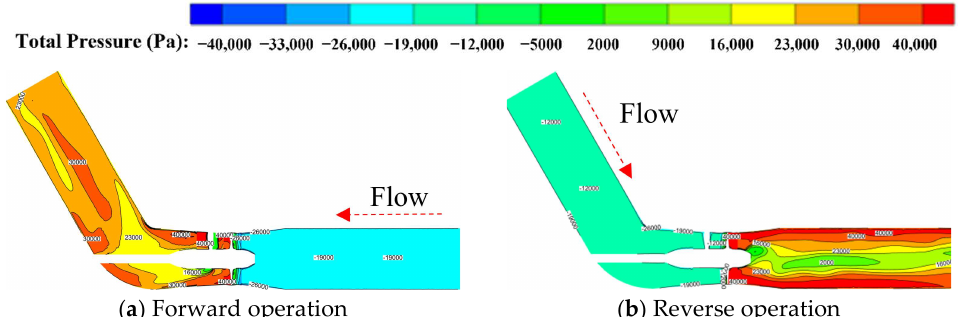
Figure 13. 0.9 Q d clouds of total pressure distribution in the middle cross section.